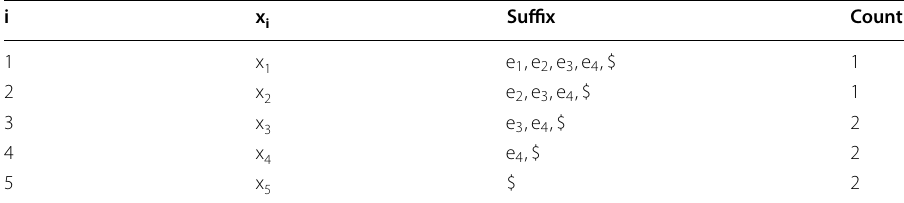
Table 4 All suffixes and their counts computed by mapper-x